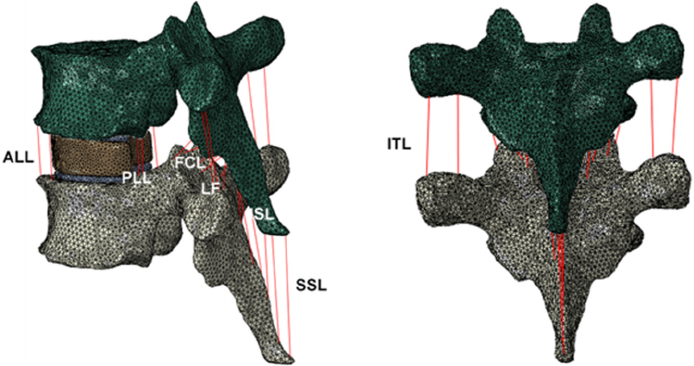
Figure 2. Three-dimensional truss ligaments modeled in the current finite element analysis. Anterior longitudinal ligament (ALL), posterior longitudinal ligament (PLL), ligamentum flavum (LF), intraspinous ligament (ISL), supraspinous ligament (SSL), intertransverse ligament (ITL), and facet capsular ligament (FCL).